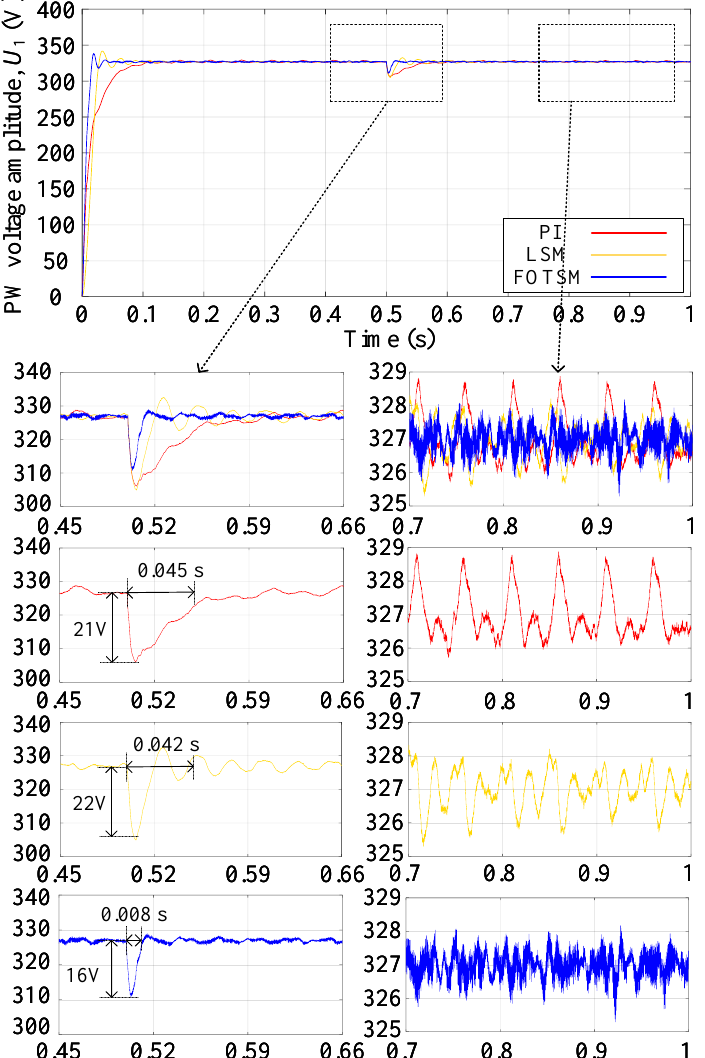
Figure 7. The PW-voltage amplitude responses under PI, LSM, and FOTSM during the load adding process.